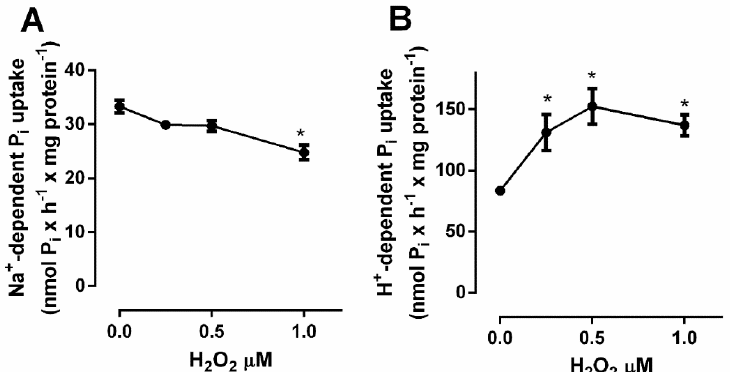
Figure 11. Effect of H 2 O 2 concentrations on Na + -dependent or H + -dependent Pi transport in MDA-MB-231 cells. Na + -dependent ( A ) or H + -dependent ( B ) Pi uptake was done for 1 h in the presence of increased H 2 O 2 (0–1 µ M) was added to the reaction mixture, as described in Section 4. The results are mean ± SE of at least three independent biological samples. * p < 0.05 indicates changes significantly different, as assessed by ANOVA followed by Tukey’s multiple comparison